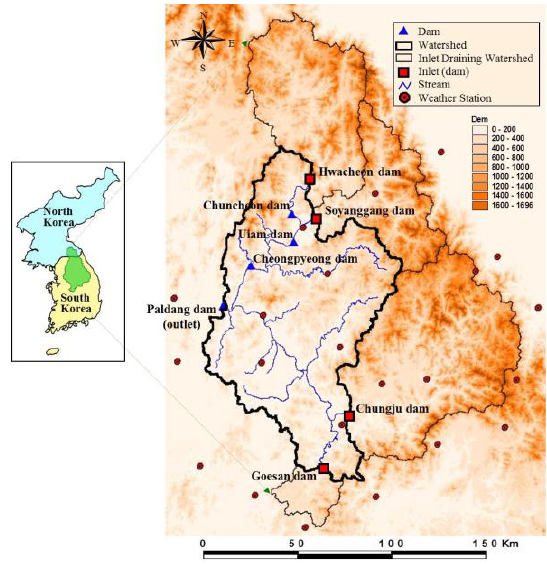
Figure 1. Study area.